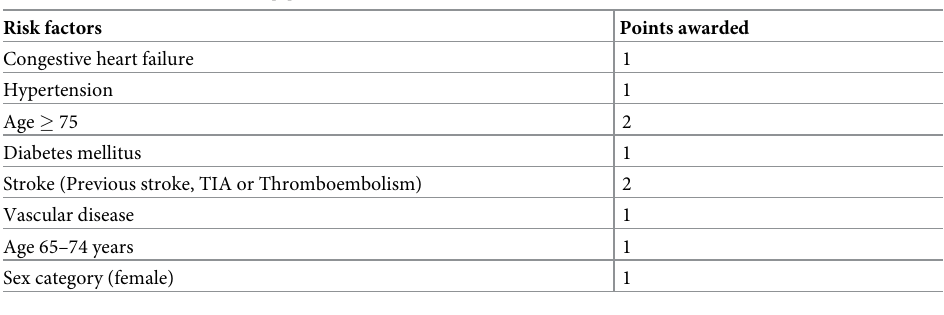
Table 1. CHA2DS2-VASc score [2].